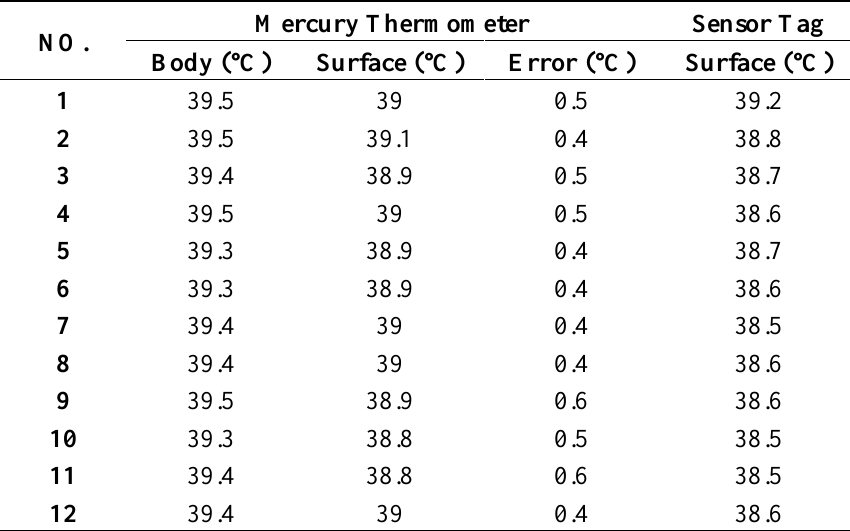
Table 2. Measurement